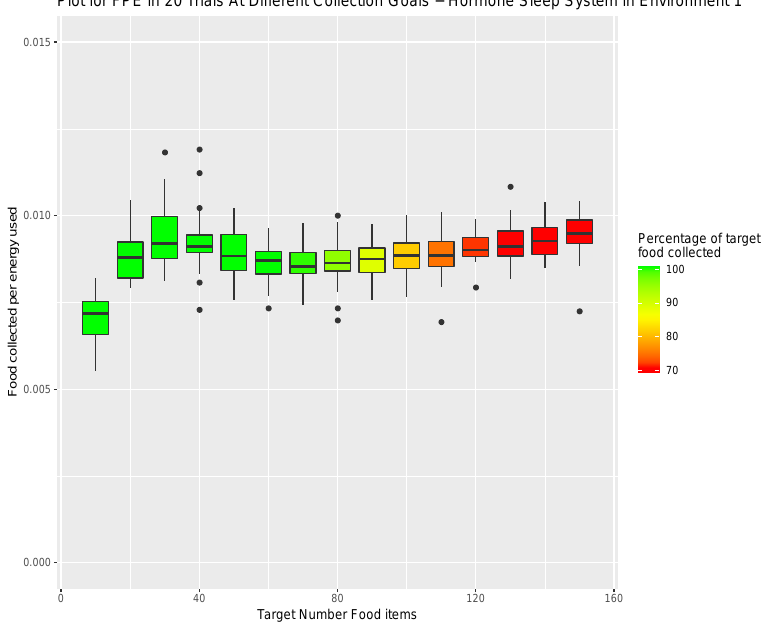
Figure 8. Hormone inspired sleep system tested in environment 1. Target number for items collected ranged from 10 to 150 items of food. Percentage of the items requested versus those collected by the end of the simulation is indicated by colour (Green 100% and Red <